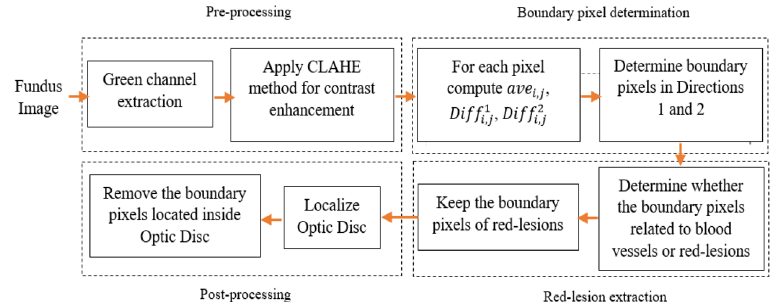
Figure 1. Block diagram for REDICA